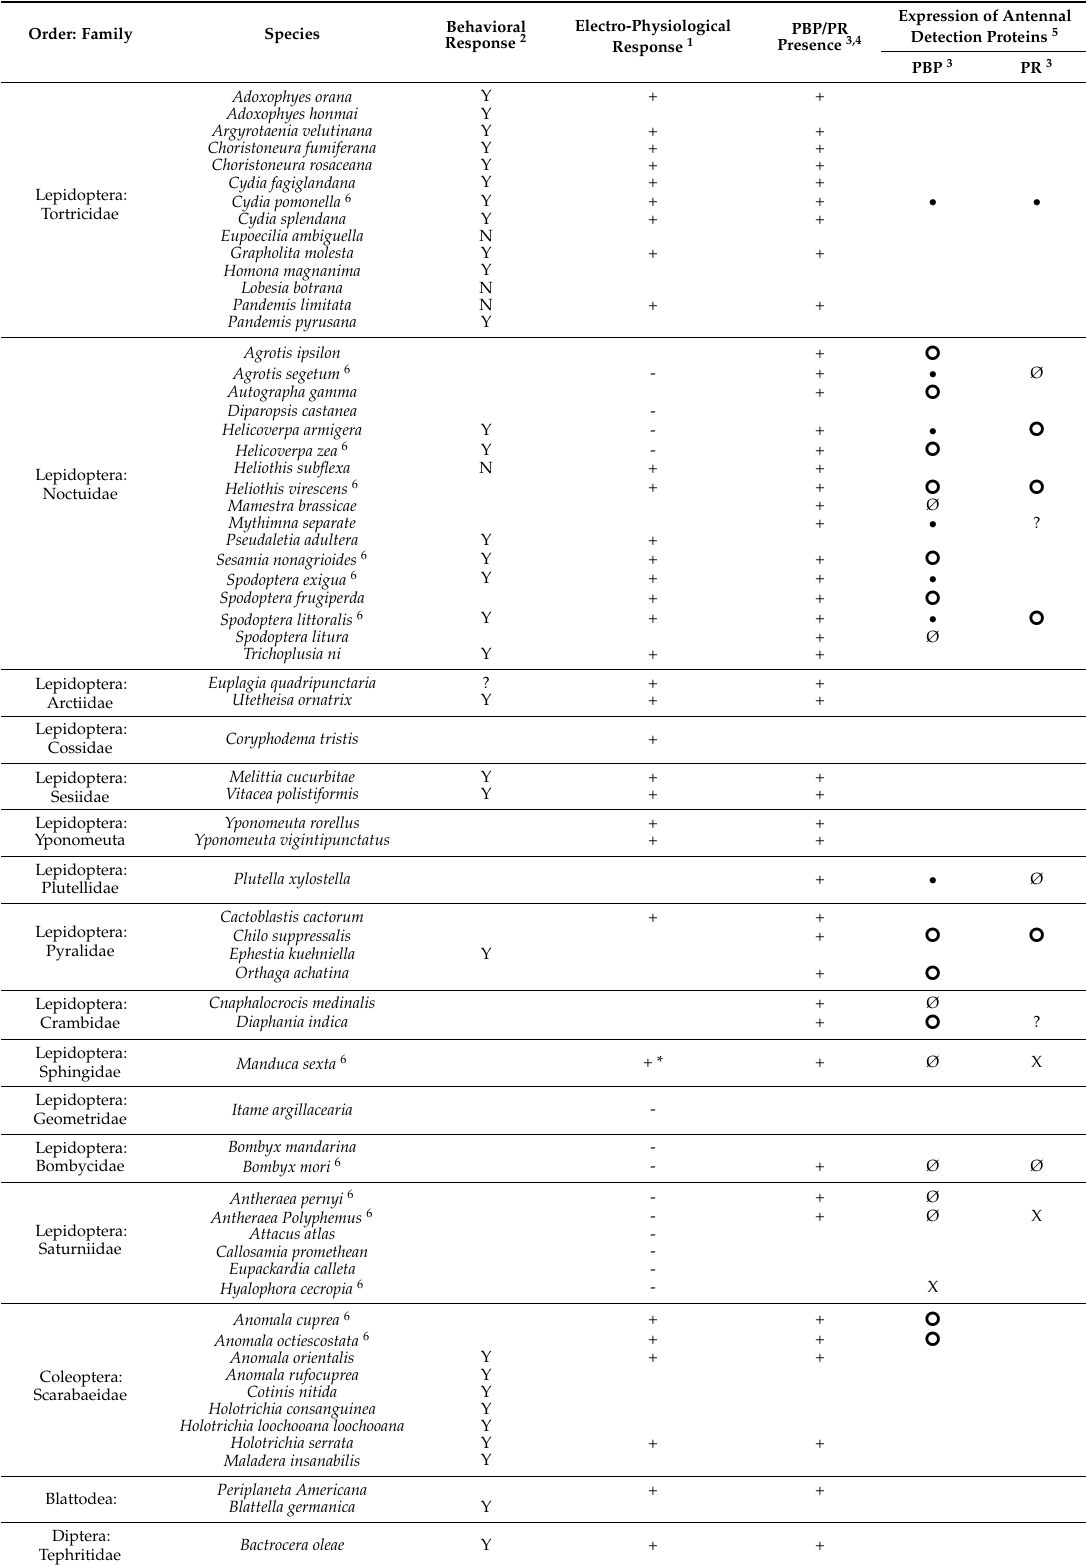
Table 4. Summary of autodetection in